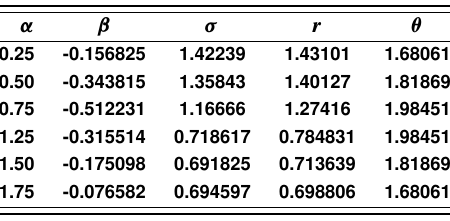
Table 1. The data for the roots of Eq. (28) for b D c D 1